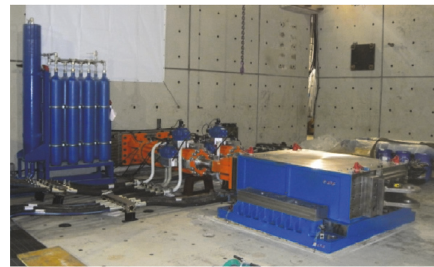
Figure 7: The damper tester.